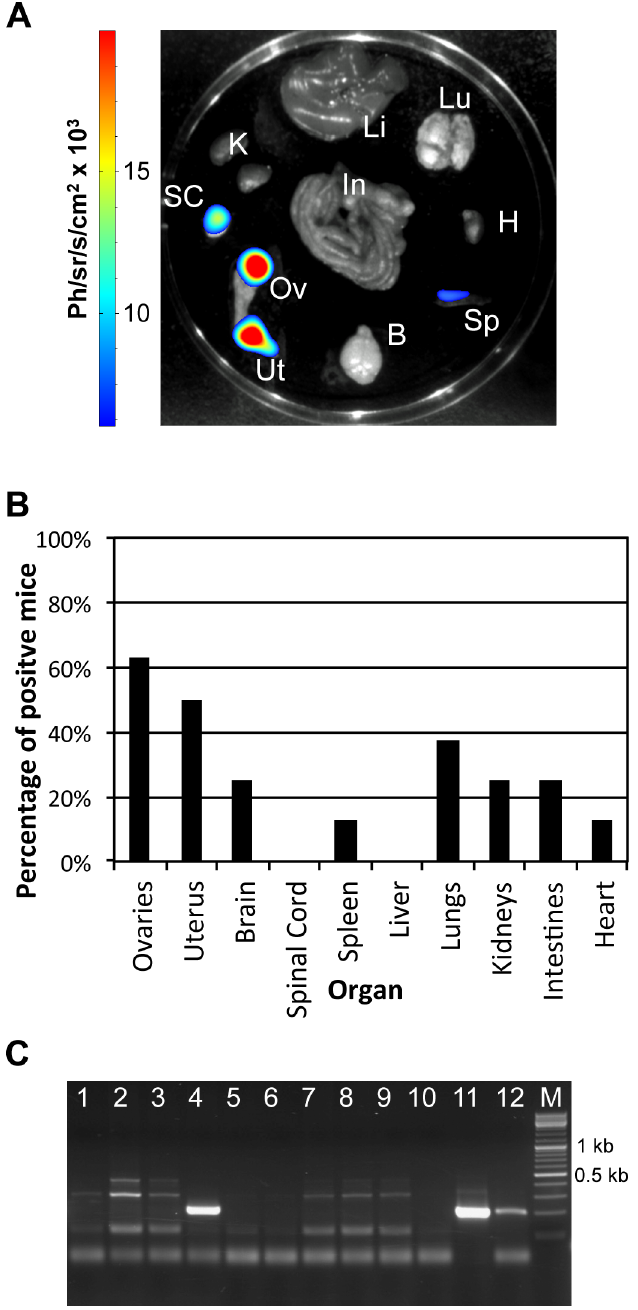
Fig 3. Investigation of the horizontal transmission of T . b . gambiense 1135 (Rluc) by crossing healthy female (n = 8) mice with infected male mice (n = 5). BLI signal from ex vivo organs of female mice (n = 8) crossed with T . b . gambiense 1135 infected males (n = 5) examined 7 months after crossing. A. BLI of ex vivo organs of a representative female mouse (mouse 229, see S3 Table). Ov, ovaries; Ut, uterus; B, brain; SC, spinal cord; Sp, spleen; Li, liver; Lu, lungs; K, kidneys; In, intestines; H, heart. The colour scale to the right of the image indicates the colour intensity in ph/sr/cm 2 /s. B. Percentage of positive female mice per organ. C. 1.8% agarose gel of PCR using pMUTec/TBingi nested primers on organs of female mice 229 and 228. Lane 1: spinal cord negative control; lane 2: spleen negative control; lane 3: ovary mouse 229; lane 4: uterus mouse 229 (band 201 bp); lane 5: spinal cord negative control; lane 6 spinal cord mouse 229; lane 7: spleen mouse 229; lane 8: ovary mouse 228; lane 9: uterus mouse 228; lane 10: spinal cord mouse 228; lane 11: genomic DNA T . b . brucei (nested PCR of the first PCR positive control); lane 12: genomic DNA T . b . brucei (nested PCR positive control); lane M: GeneRuler DNA ladder (ThermoScientific).